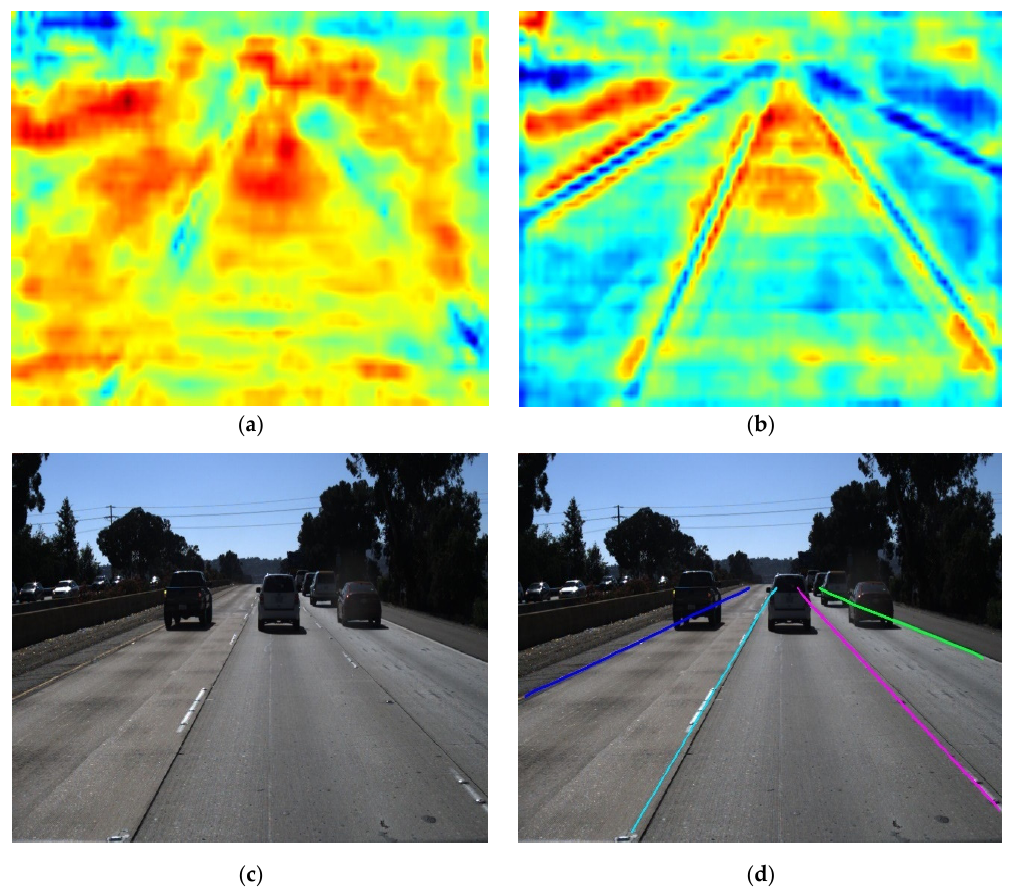
Figure 16. Visualization of the lane line detection process. ( a ) Before feature enhancement. ( b ) After feature enhancement. ( c ) Input image. ( d ) Detection result.